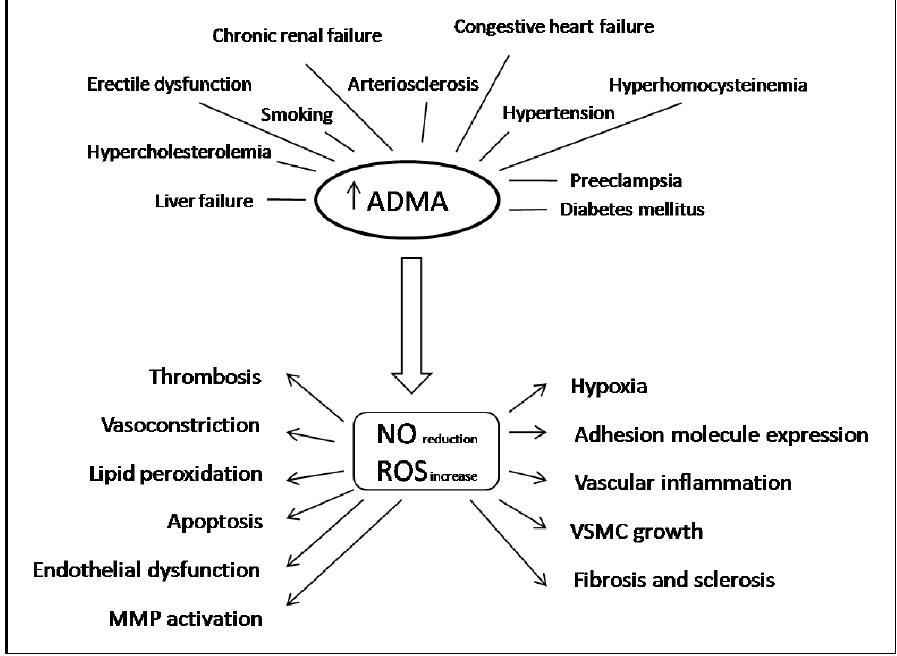
Figure 2. Flow diagram outlining clinical conditions that have been reported to be associated with elevated ADMA concentration, and the interactive roles of ROS and ADMA in relating cardiovascular risk factors to pathophysiological changes in tissues that may underlie cardiovascular disease. ROS, reactive oxygen species; MMP, matrix metalloproteinase; VSMC, vascular smooth muscle